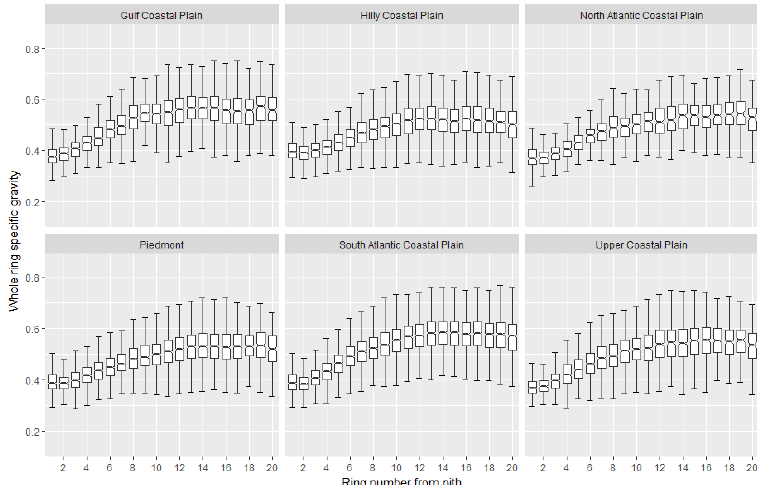
Figure 2. Plot showing the trend in whole ‐ ring specific gravity (SG) from pith to bark (ring number from pith) at breast height for loblolly pine. Here, the notched point represents the median, the filled diamond represents mean ring SG, the range of the box represents interquartile range, and lines represent the range of ring SG (minimum, maximum) within each annual ring from pith to bark (data collected by the Wood Quality Consortium at the University of Georgia).